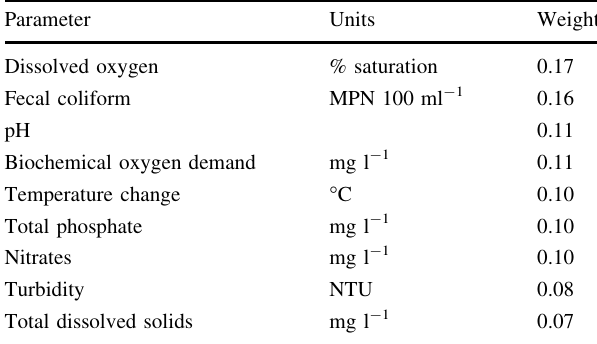
Table 2 Water quality parameters and weights based on NSF-WQI (after WU 2014)